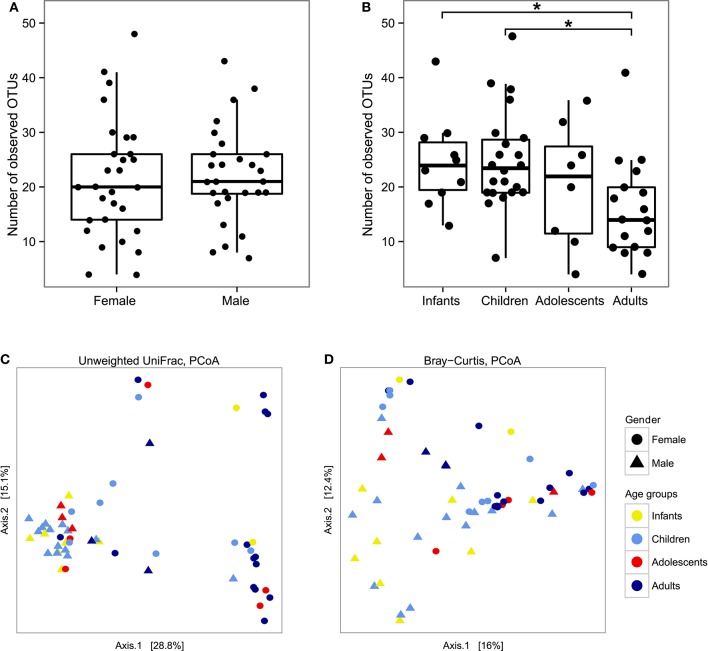
Box-plot representation of fungal alpha-diversity measures using the number of observed OTUs between (A) genders or (B) age groups and measures of fungal beta-diversity by PCoA of the between samples distances measured using (C) the unweighted UniFrac distance and (D) the Bray-Curtis dissimilarity. *p < 0.05, Wilcoxon rank-sum test.